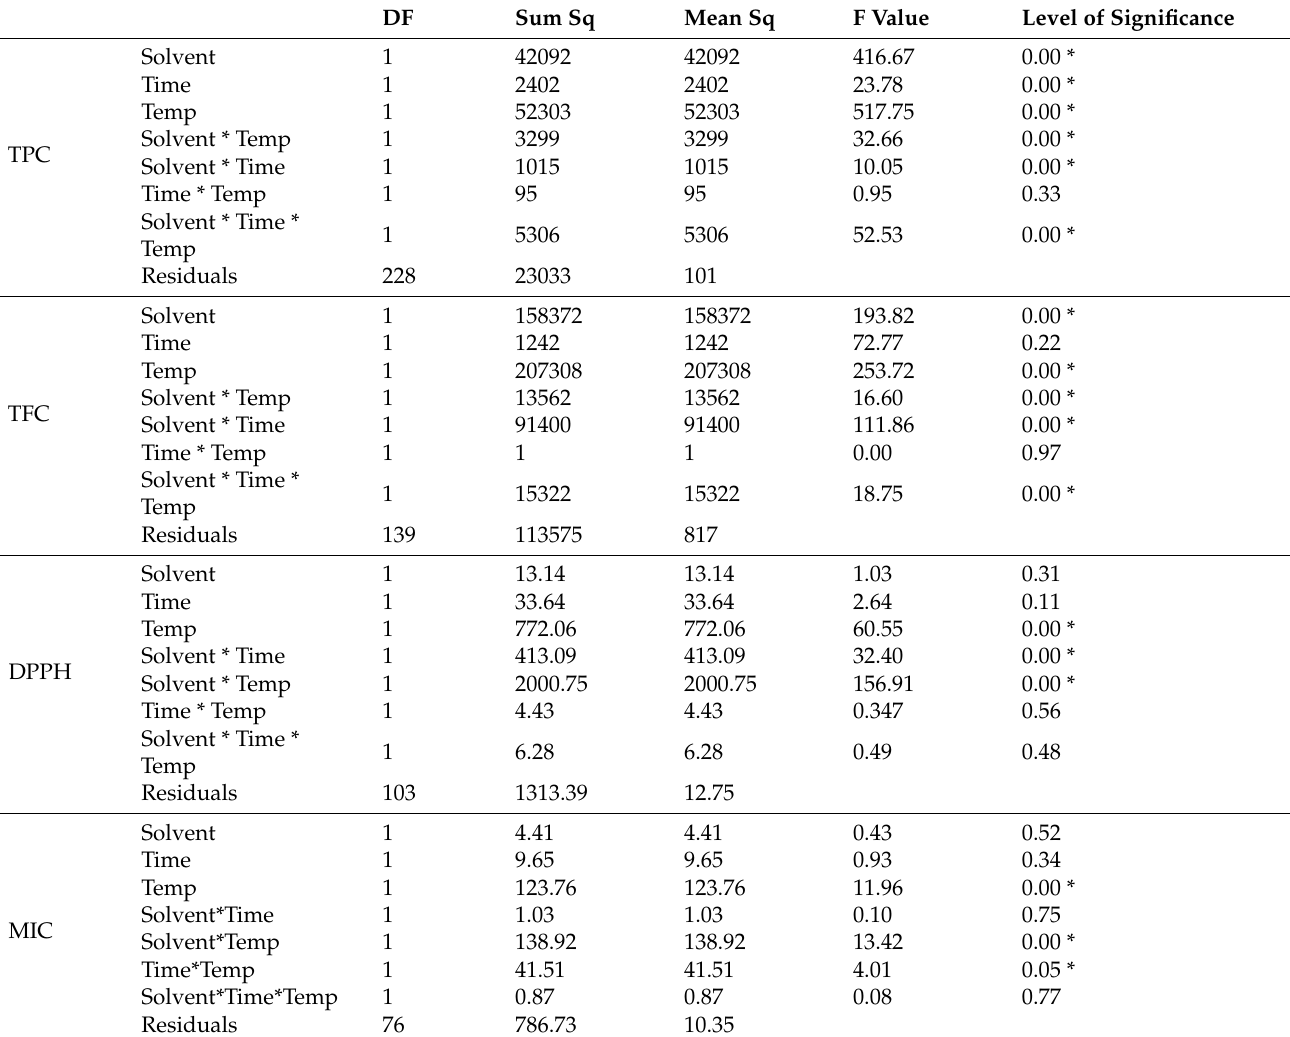
Table 5. Three-way Analysis of variance (ANOVA) table for the Antioxidant